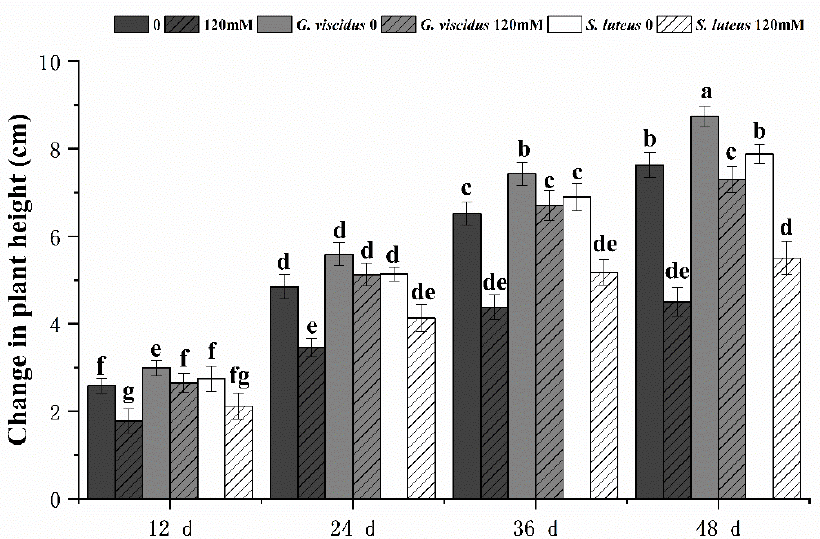
Figure 2. Changes in plant height in ectomycorrhizal seedlings of Q. mongolica under NaCl stress. Bars represent means of five replicates (±SD). For each parameter, bars with different letters indicate significant differences among treatments, p ≤ 0.05, following one-way ANOVA.